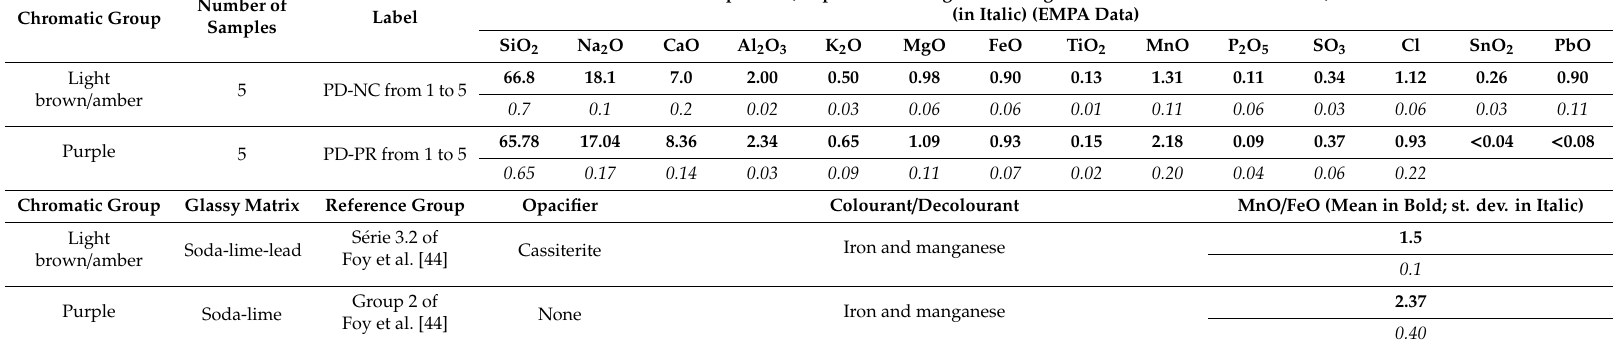
Table 1. Summary of the main archaeometric results obtained on light brown / amber and purple tesserae from palaeo-Christian mosaic of St. Prosdocimus (Padova, Italy), showing the manganese-containing inclusions, which are the object of the present paper. In the case of chemical composition of tesserae, note that total iron and total manganese are expressed as FeO and MnO, respectively; in addition, contents of cobalt, copper, zinc, and antimony were also measured, but not reported here, because these elements are all under EMPA detection limits, equal to 0.03 wt% for CoO and CuO, and 0.04 wt% for ZnO and Sb 2 O 3 (raw data from